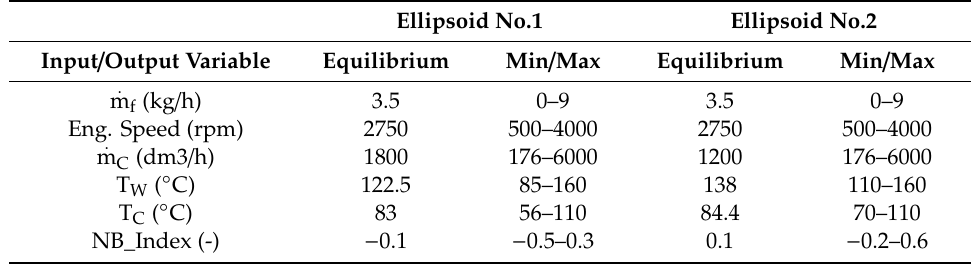
Figure 11. Control region and system trajectory during the NEDC for moderate boiling levels.